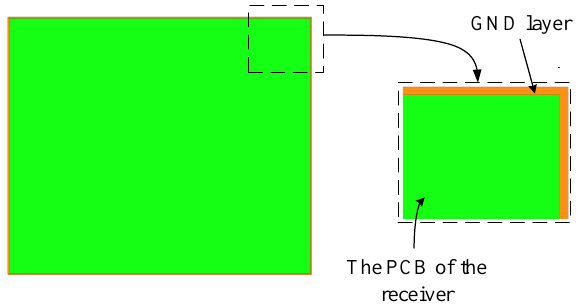
Figure 3. View of the bottom side of the receiver board.